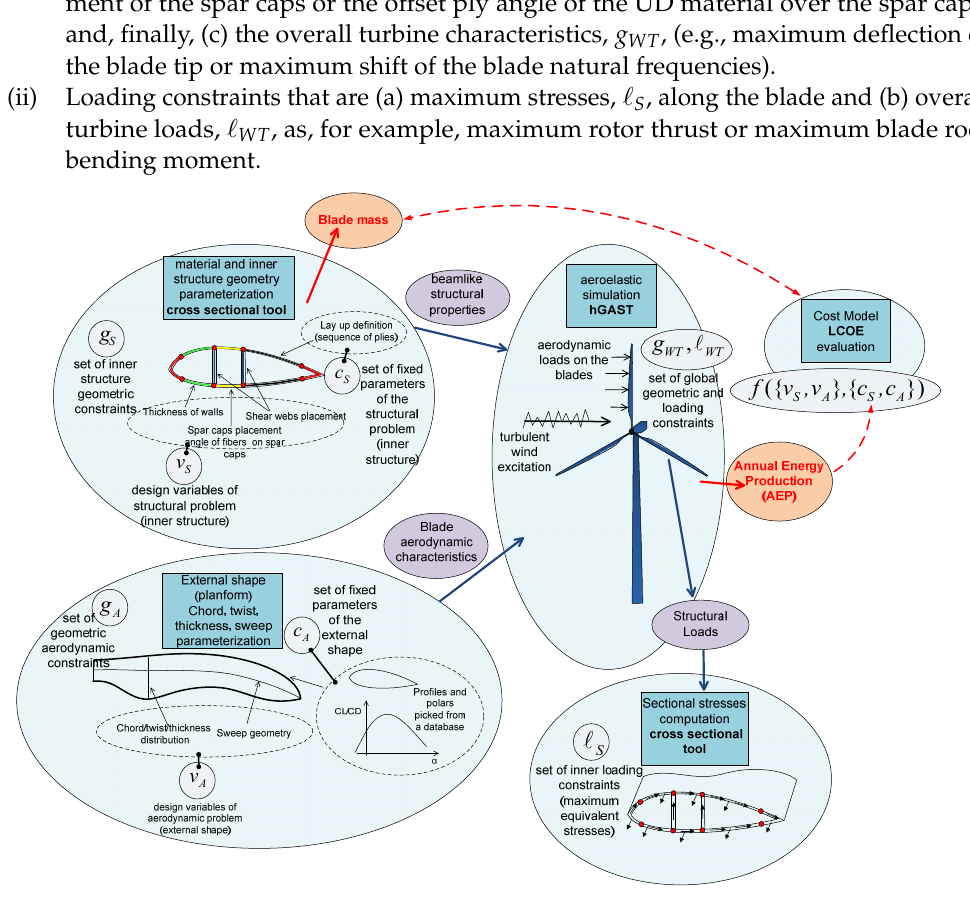
Figure 3. Overview of the optimization process.